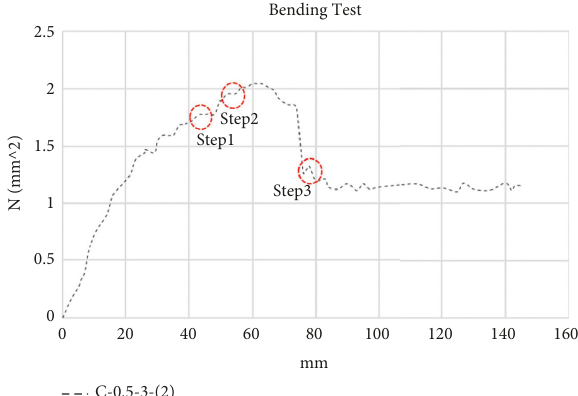
Figure 15: The tension-displacement diagram for the C-0.5-3(2) panel in the bending